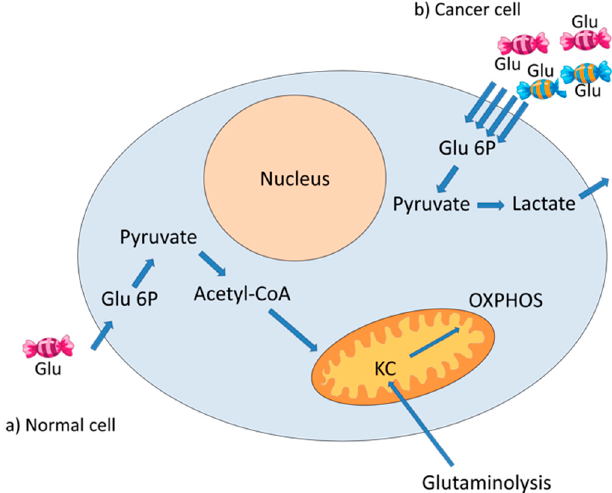
Figure 2. Metabolism of glucose in normal and cancer cells. The glucose (Glu) that enters the cell is phosphorylated to glucose 6 phosphate (Glu 6P) and, subsequently, is metabolized to pyruvate ( a , b ). In normal cells, pyruvate is metabolized to acetyl-coenzyme A (Acetyl-CoA) and continues its metabolism in the Krebs cycle (KC) and the oxidative phosphorylation (OXPHOS) system ( a ). In cancer cells, glucose entry is increased, and pyruvate is metabolized to lactate, which is then expelled from the cells ( b ). The Krebs cycle can be fed by intermediaries from glutaminolysis.